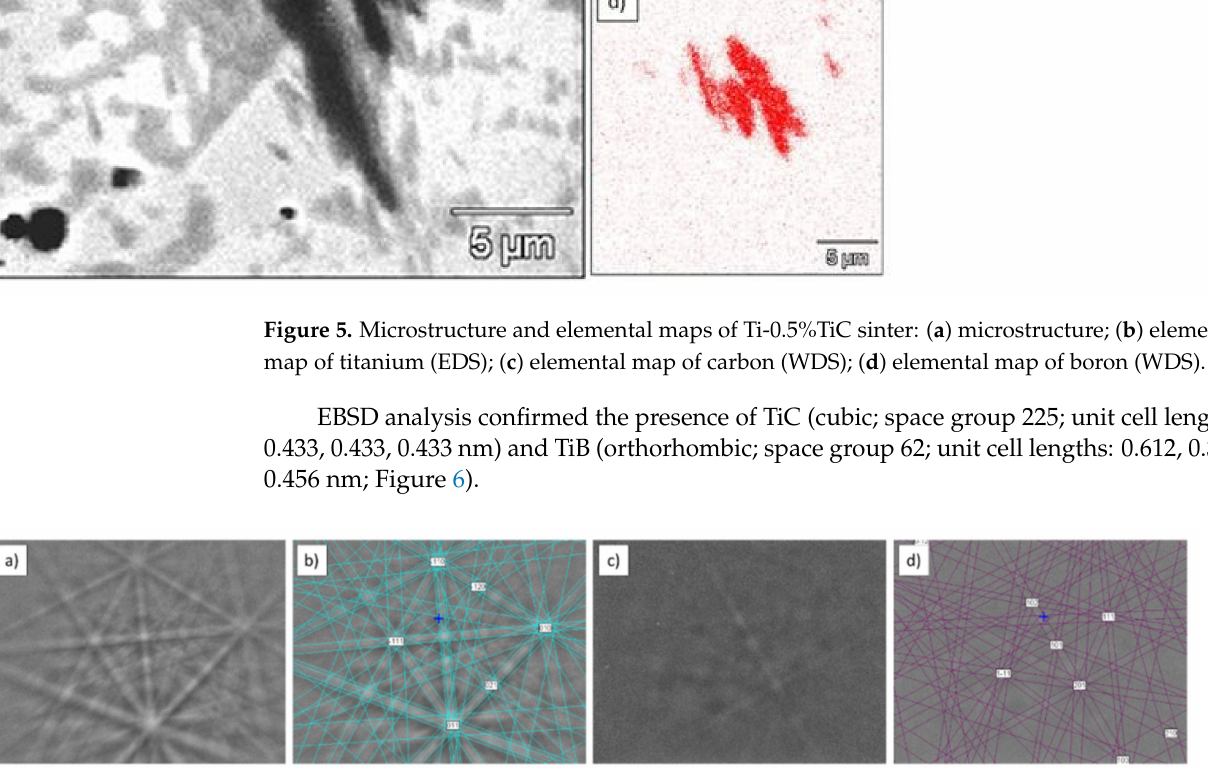
Figure 6. EBSD analysis of Ti–0.5%TiC sinter: ( a ) Kikuchi pattern of TiC phase; ( b ) indexed Kikuchi pattern of TiC phase; ( c ) Kikuchi pattern of TiB phase; ( d ) indexed Kikuchi pattern of TiB phase. The Ti–1.0%TiC sinter contained titanium carbide particles and particles with boron (Figure